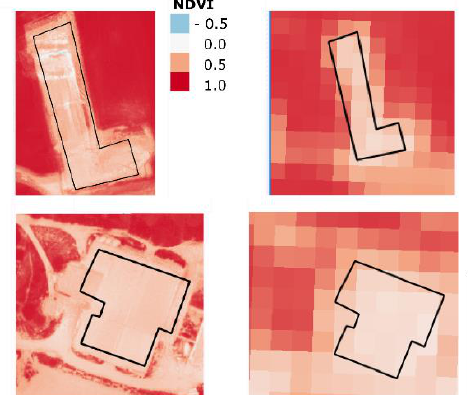
Figure 4. Comparison between NDVI calculated using RPAS images with resolution of 20 cm/pixel (left) and Sentinel 2 images with resolution of 10 m/pixel (right). NDVI values obtained with using the band 8 (Figure